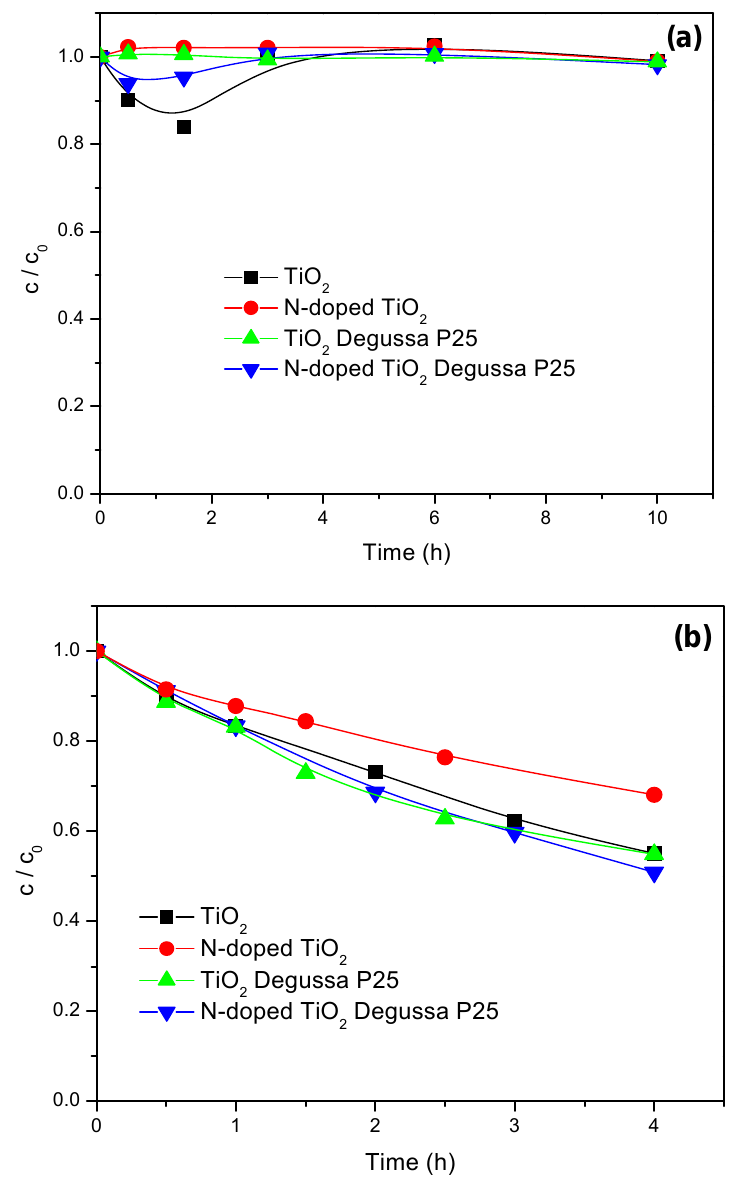
Figure 6. Disappearance of clopyralid (1.0 mmol/dm 3 ) under visible (a) and UV (b) light irradiation (1.0 mg/cm 3 of